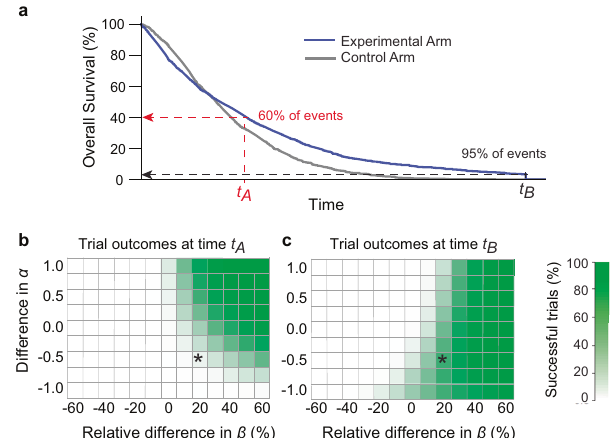
Fig. 7 Effect of trial duration on success when proportional hazards are violated. a One of many simulated trials having a range of Weibull α and β parameters similar to those observed in actual trials reporting OS data; in this trial, Δ α = − 0.5 and the ratio of β for experimental and control arms was 1.2. The labels t A and t B denote times corresponding to approximately 60% or 95% of all trial events (for real OS trial arms in this article, in metastatic cancers, these event rates correspond to median times of t = 22 months and t = 50 months). b Percent of simulated successful A B trials at time t A or c t B . The simulated trial depicted in panel a is denoted by an asterisk. “ Success ” was scored as a hazard ratio less than one at a 95% con fi dence level using the Cox proportional hazards regression; this metric was used despite the violation of proportional hazards because it is the accepted approach for assessing ef fi cacy in pivotal trials (see text and “ Methods ” for